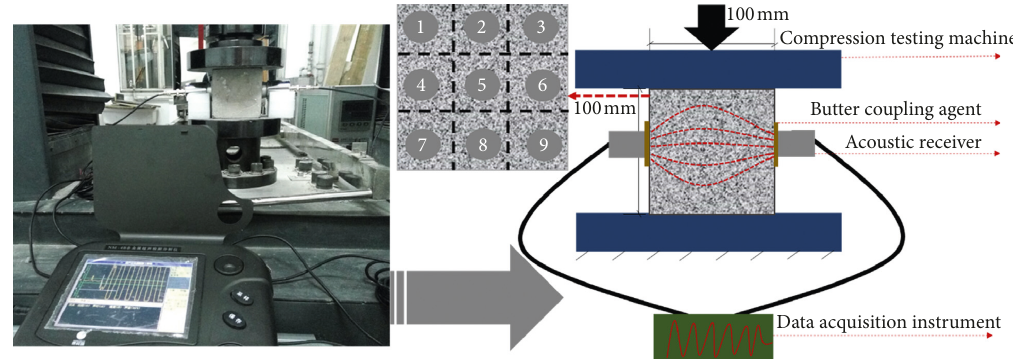
Figure 2: Loading test and test method of imposed load damage.